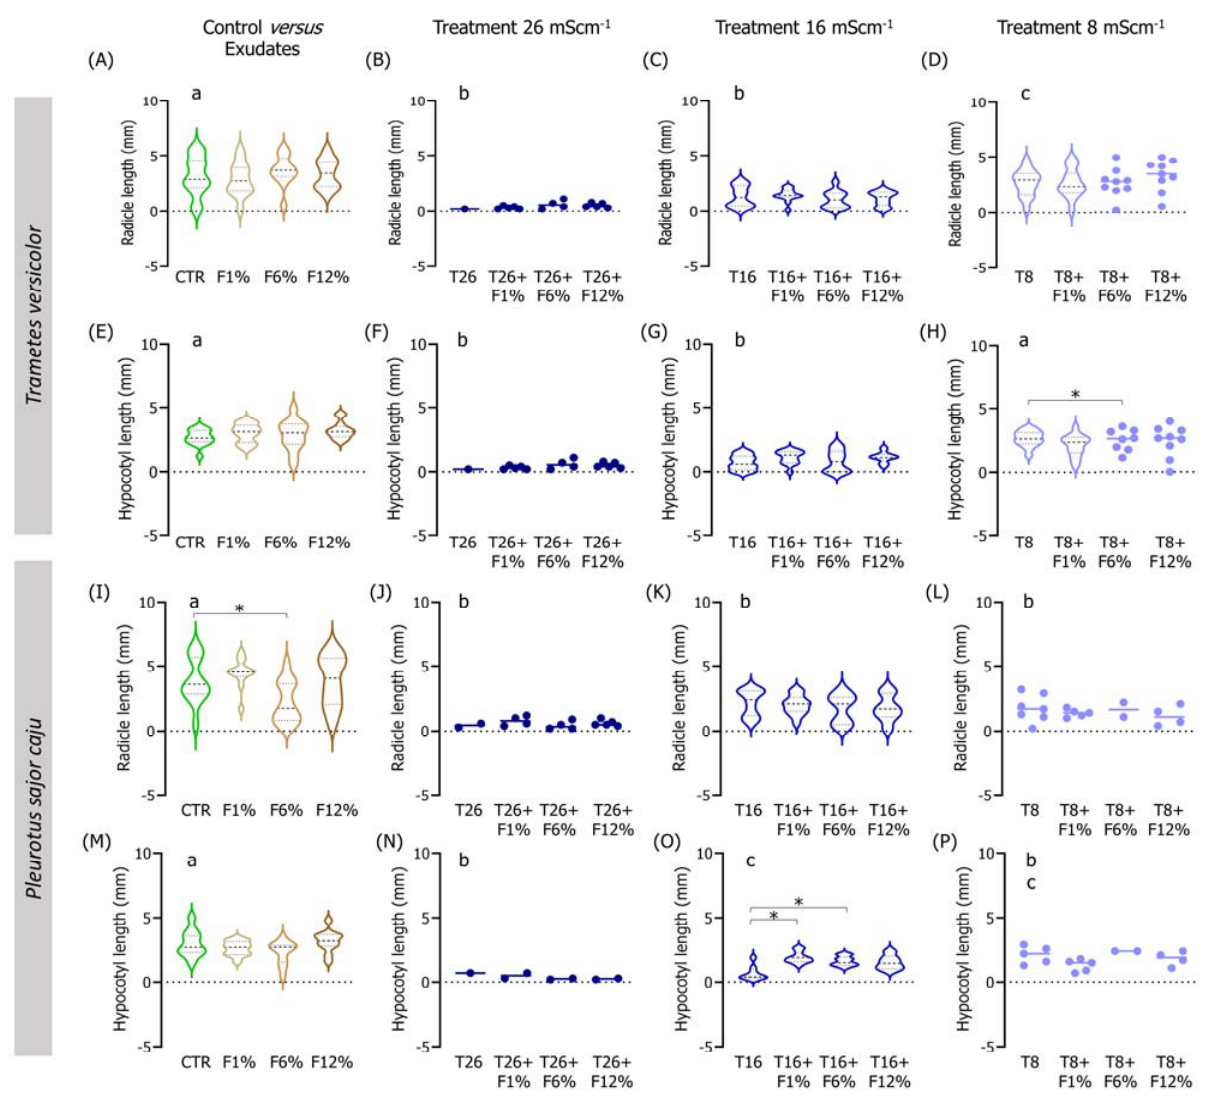
Figure 3. Violin plots of the seedling length of Lens culinaris germinated in natural soil salinized at three different levels (8, 16, and 26 mS.cm − 1 , designated as T8, T16, and T26, respectively) and supplemented with fungi exudates at three levels (1%, 6, and 12%, designated as F1%, F6%, and F12%, respectively). Graphics ( A – H ) present the results obtained from soil moistened with Trametes versicolor exudates, and graphics ( I – P ) present the results obtained from soil moistened with Pleurotus sajor caju exudates. CTR stands for control soil. Letters (a, b, c) stand for homogenous groups assessed only between CTR and the salinity treatments at 96-h in each assessed endpoint